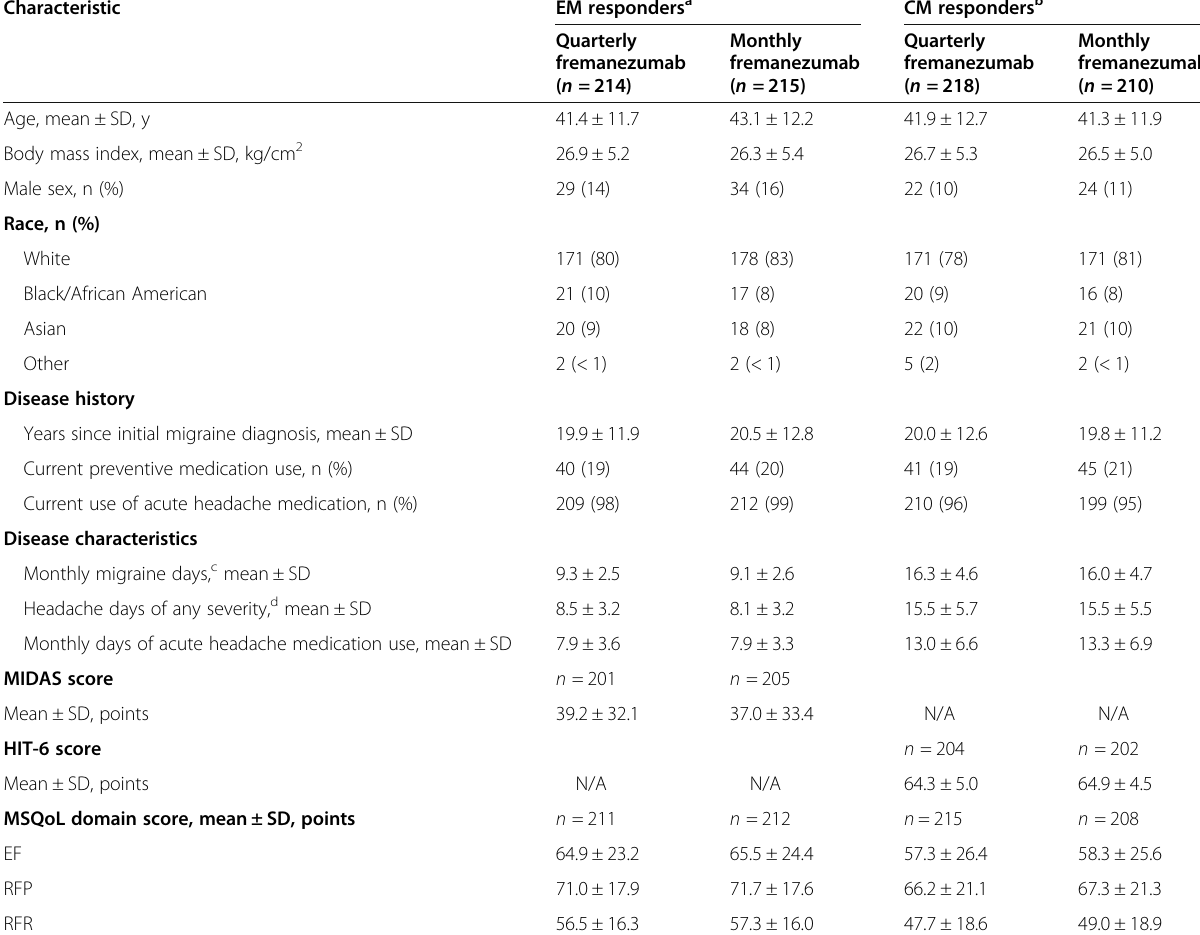
Table 1 Demographics and baseline characteristics for participants who responded to treatment